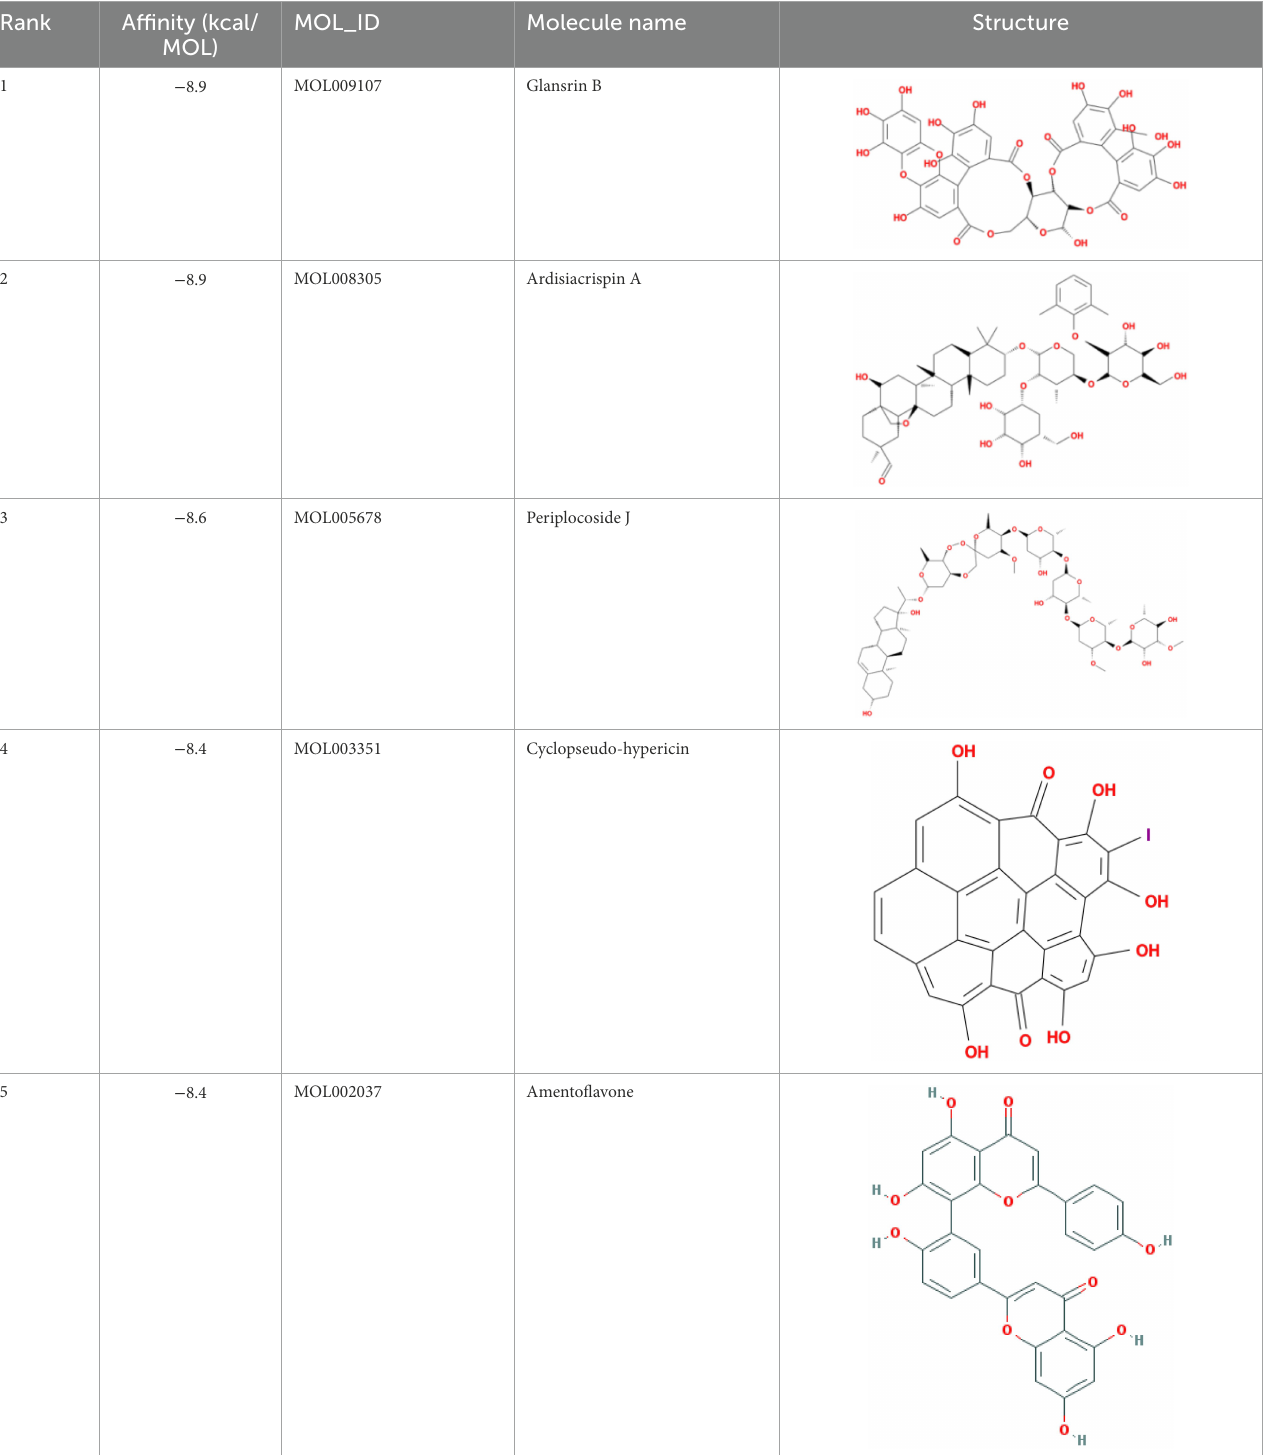
TABLE 4 Molecular docking results of Delta S-CTD mutant bases and compounds.